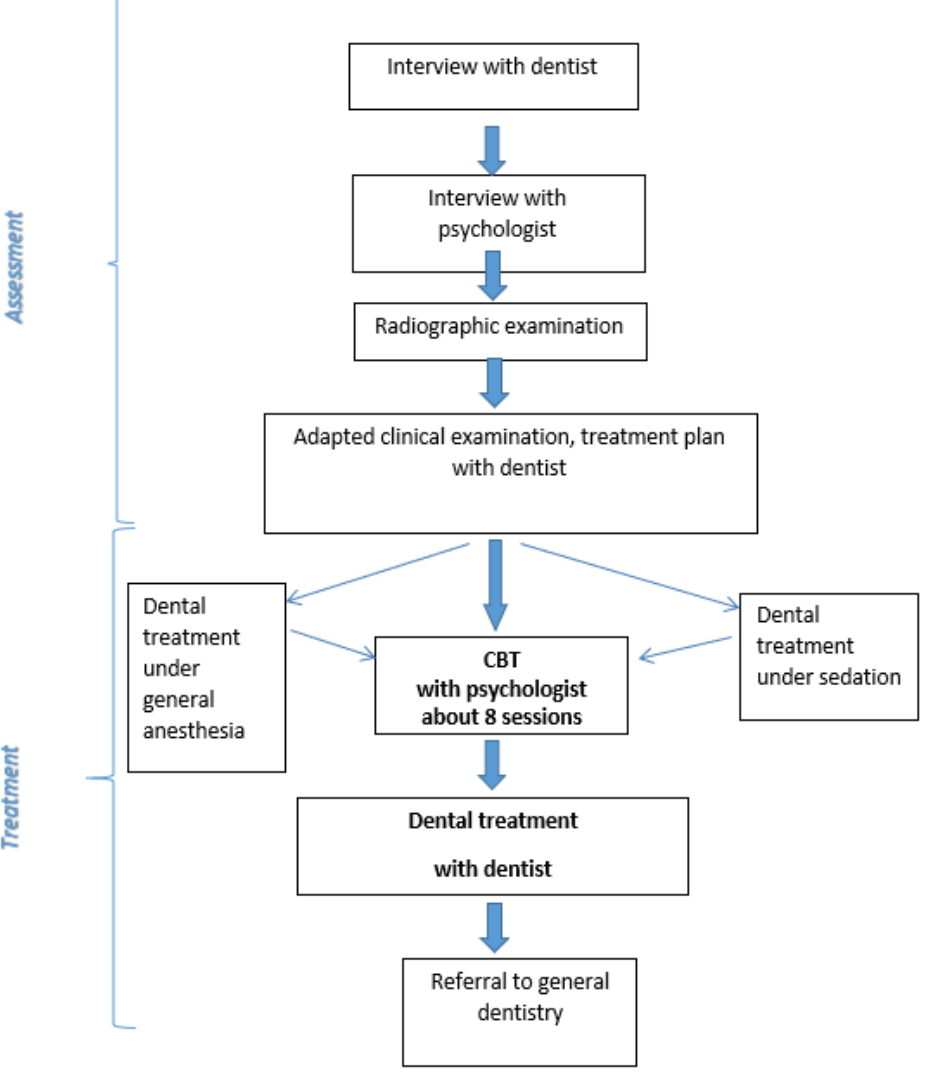
Figure 4. Flowchart for CBT treatment of dental anxiety/phobia [27].